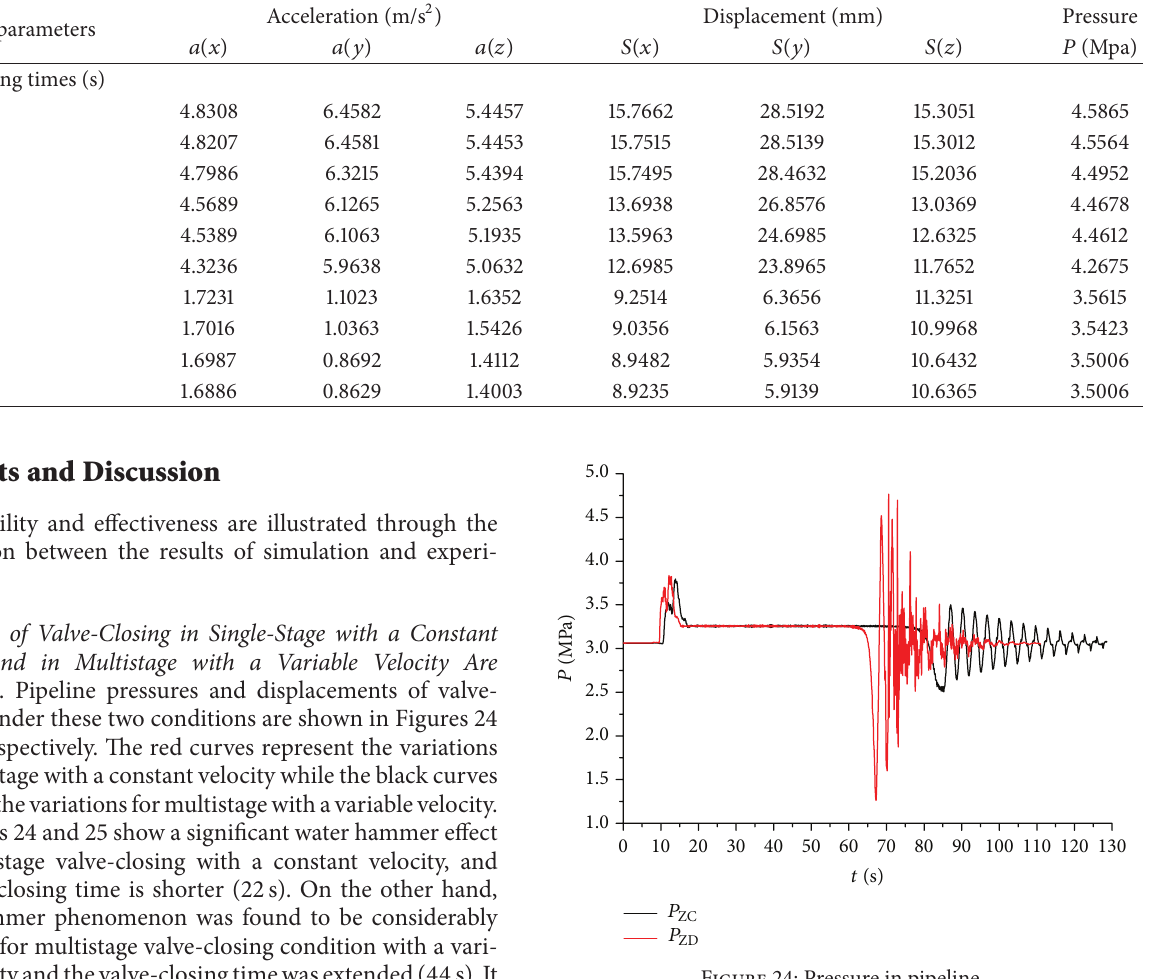
Figure 24: Pressure in